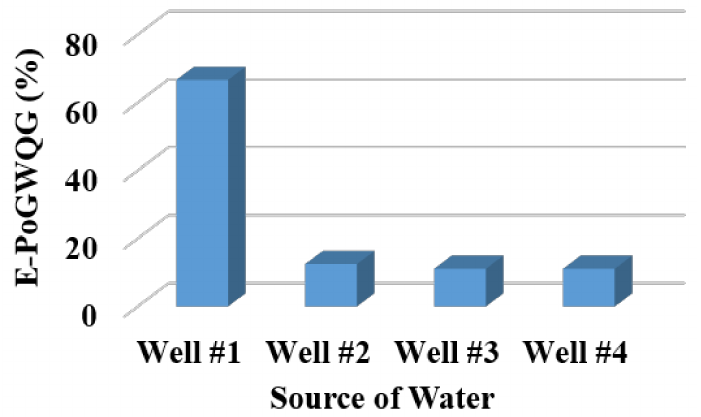
Figure 4. PoGWQGs and PaGWQGs in the West Bank.